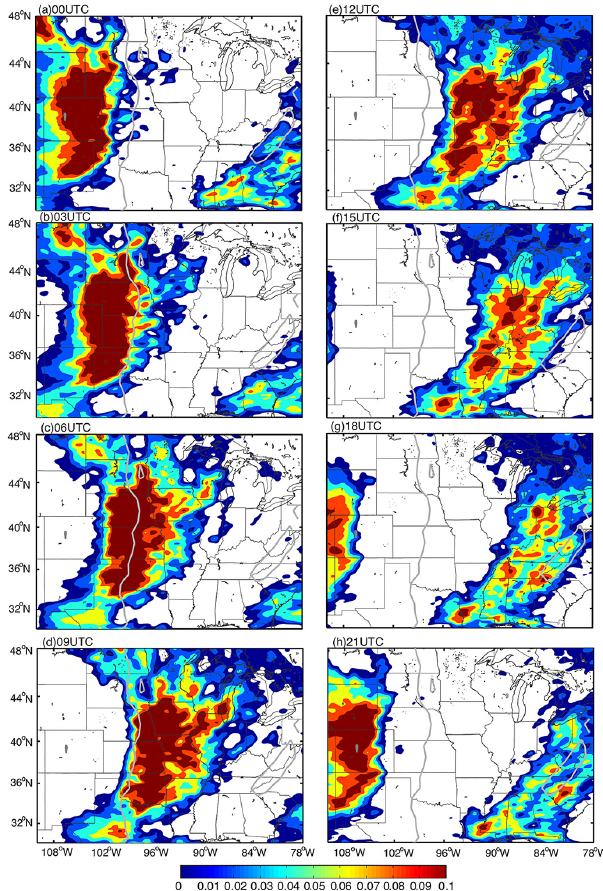
Figure 12. Similar to Fig. 3 but for the filtered precipitation per- turbations (units: mmh − 1 ) over the spectral range bounded by the phase speed between 13 and 30ms − 1 over North